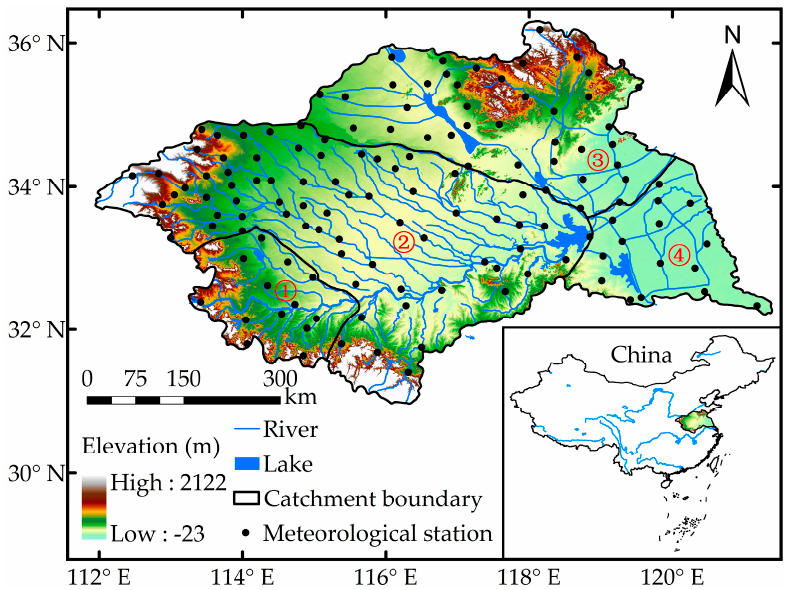
Figure 1. The location of the Huai River Basin (HRB) in China and its spatial distributions of the elevation, meteorological stations and the river system, four sub-regions represent ① : Upper HRB, ② : Middle HRB; ③ : Yi-Shu-Si River Basin; and ④ : Lower HRB, respectively.